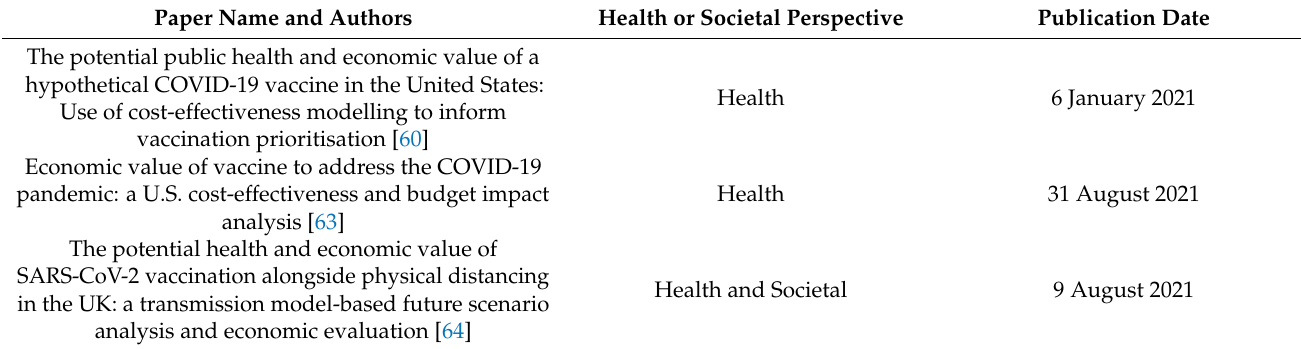
Table 4. Selection of HTA studies evaluating cost-effectiveness of COVID-19 vaccination